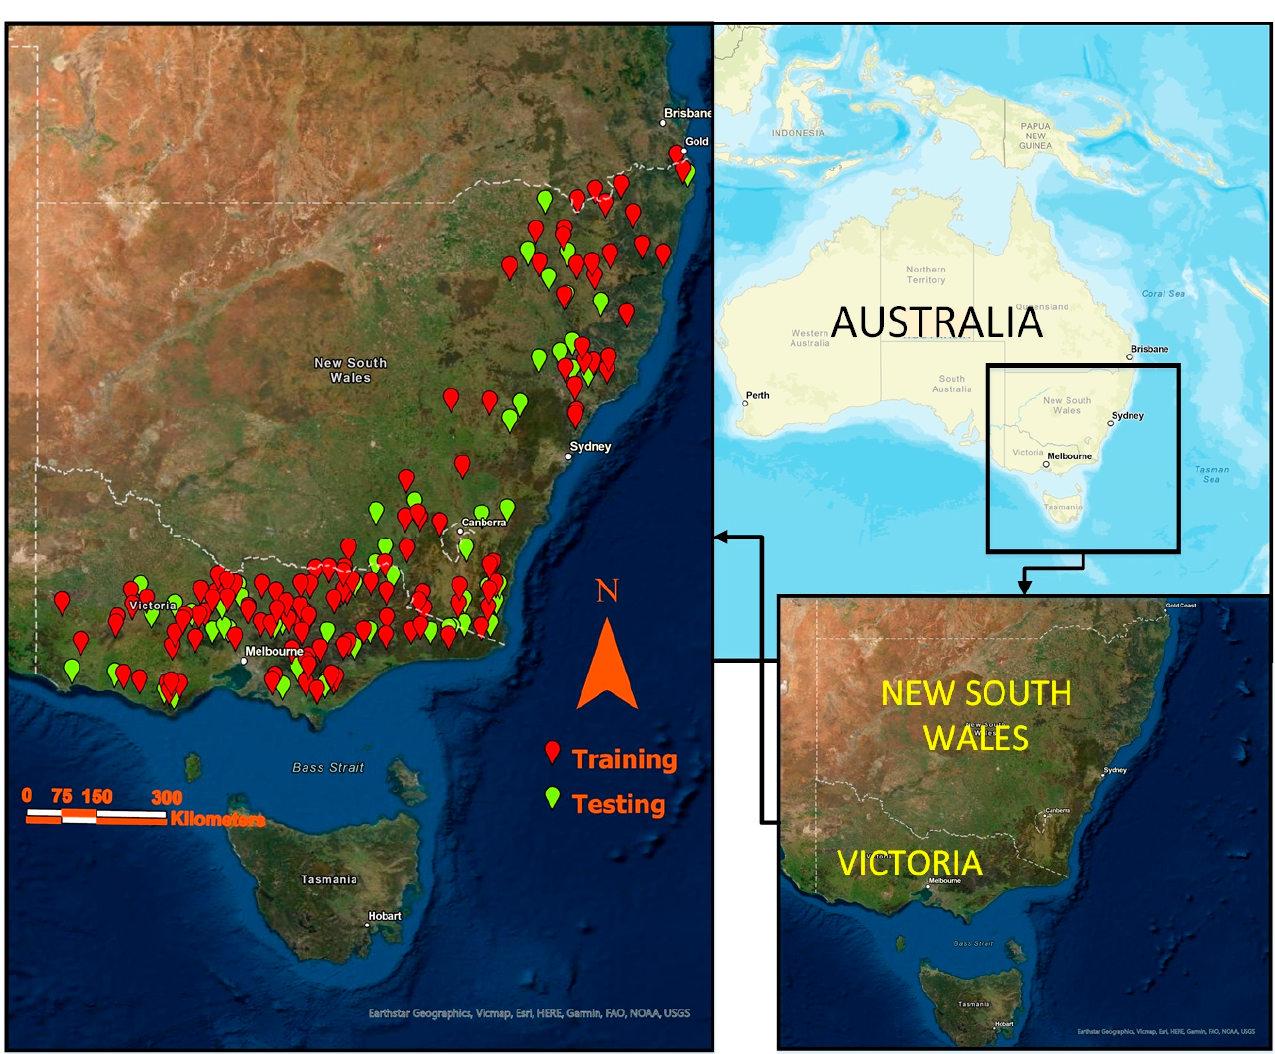
Figure 1. Study area and selected